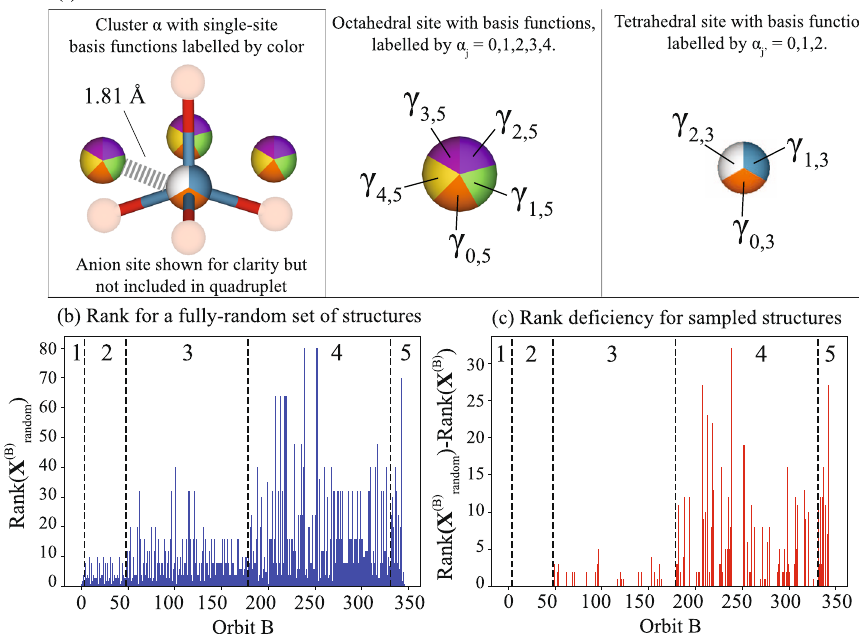
Fig. 3 Rank de fi ciency in high-component ionic systems. a Illustration of the cluster α with single site basis functions labelled by color. Since the zeroth label is independent of occupation and is always 1, the colors are the same (orange). However, since the rest of the basis functions ( σ γ α j > 0 ; n i i ð Þ ) are dependent on occupation, they are differently colored. b Rank of all orbits B for the fully random set of structures and the ( c ) rank de fi ciency of all orbits B for the set of structures in this study. The size of the cluster generating orbit B is indicated for points (1), pairs (2), triplets (3), quadruplets (4), and quintuplets